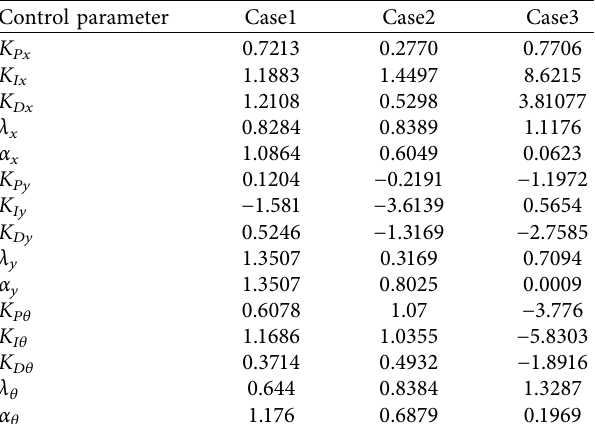
Table 6: The control parameters of NNFOPID controller by